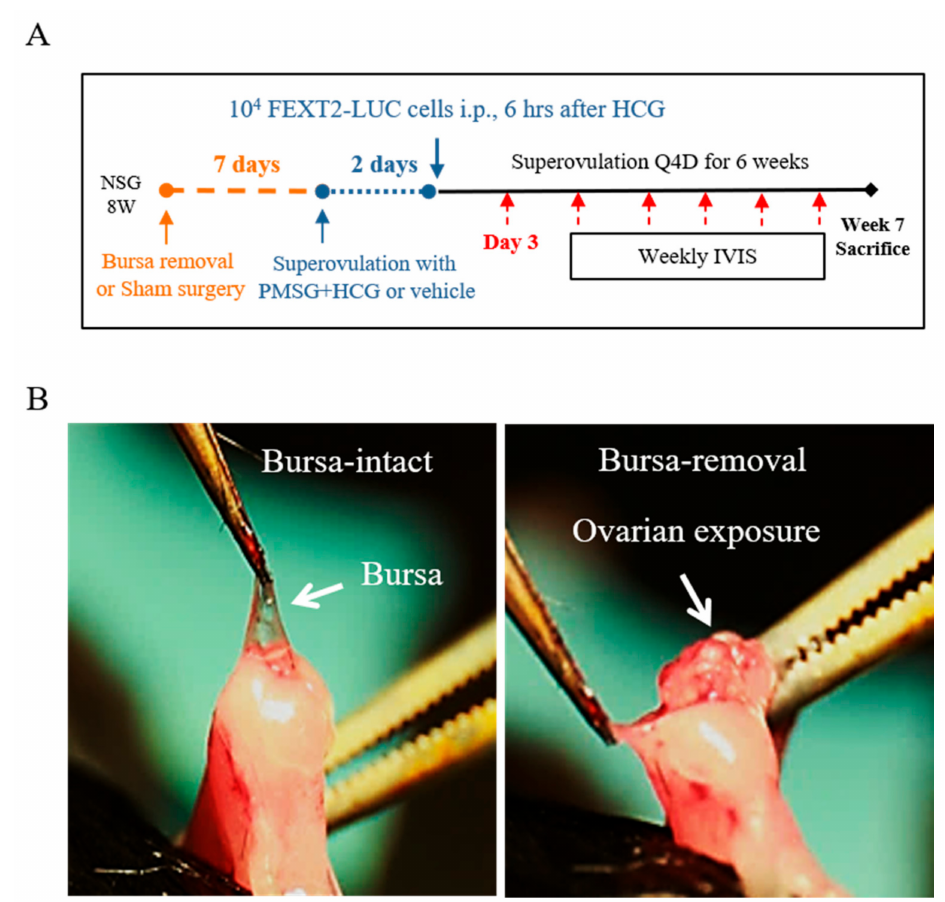
Figure 1. Schema of bursa removal, superovulation, and intraperitoneal injection in NSG mice. ( A ) Timeline of animal procedures. On the seventh day after the bursa removal or sham operation, mice were subjected to superovulation with PMSG/HCG or PBS as a control every 4 days until sacrifice. Two days later, 1 × 10 4 FEXT2-LUC cells were injected i.p. Mice were followed weekly with IVIS. ( B ) Symbolic picture for bursa removal